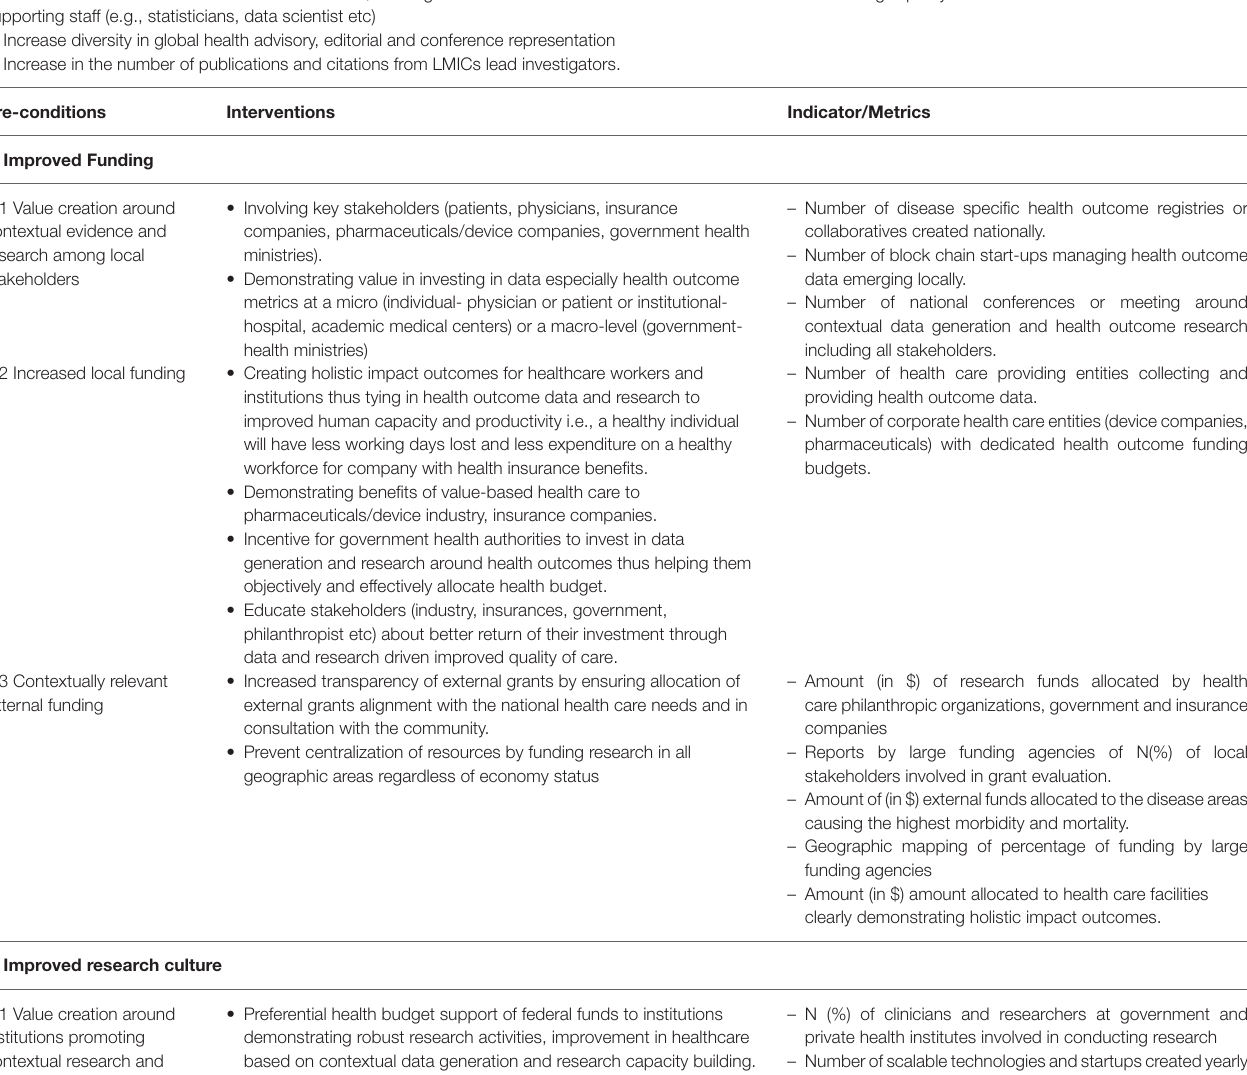
TABLE 1 | A theory of change model to increase data generation and contextual research in low- to middle- income countries. Impact: Improved evidence generation and contextual research for optimal CHD care N (%): Increase in available health outcome metric datasets, increase in number of papers on data from LMIC authored by investigators from Global south. Intermediate Outcome: Improved resources, representation, and publications N